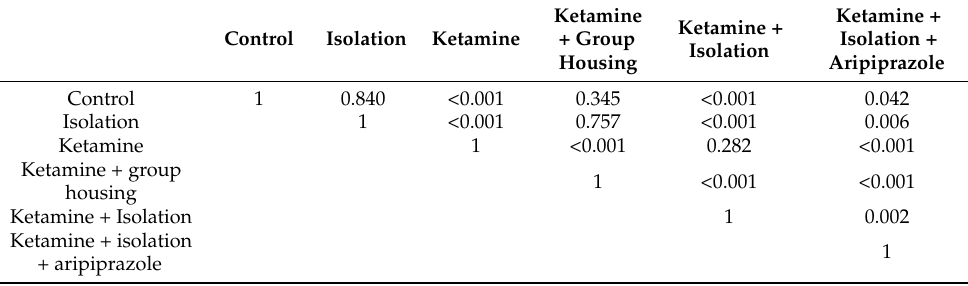
Figure 3. Behavioral results in the elevated plus maze of the six analyzed groups based on the number of open arms entries. The values are mean. * Significantly different when compared to control group ( p < 0.05). Table 4. All p -values for the number of open arms entries in the elevated plus